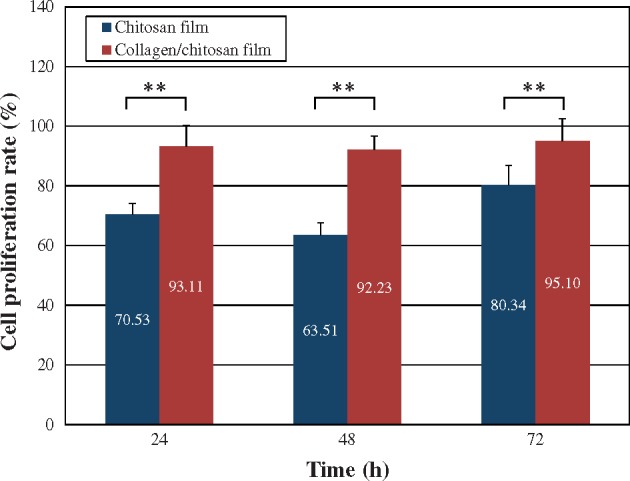
The cell proliferation rate of the PC12 cells cultured on both surfaces changed at different time points. Results were expressed as mean ± SD (n = 6). **P < 0.01